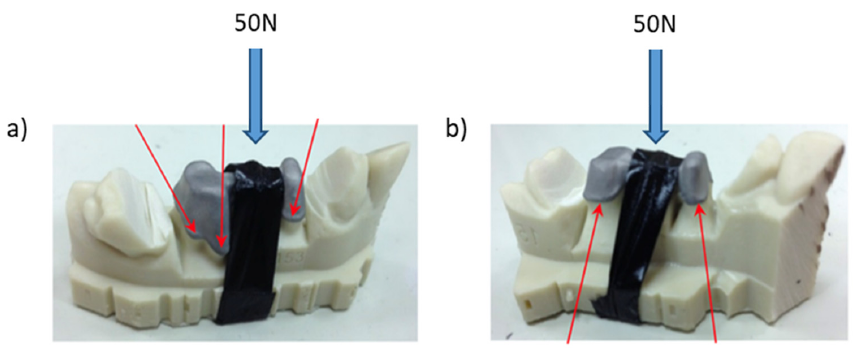
Figure 2. Metals 2020 , 10 , x FOR PEER REVIEW